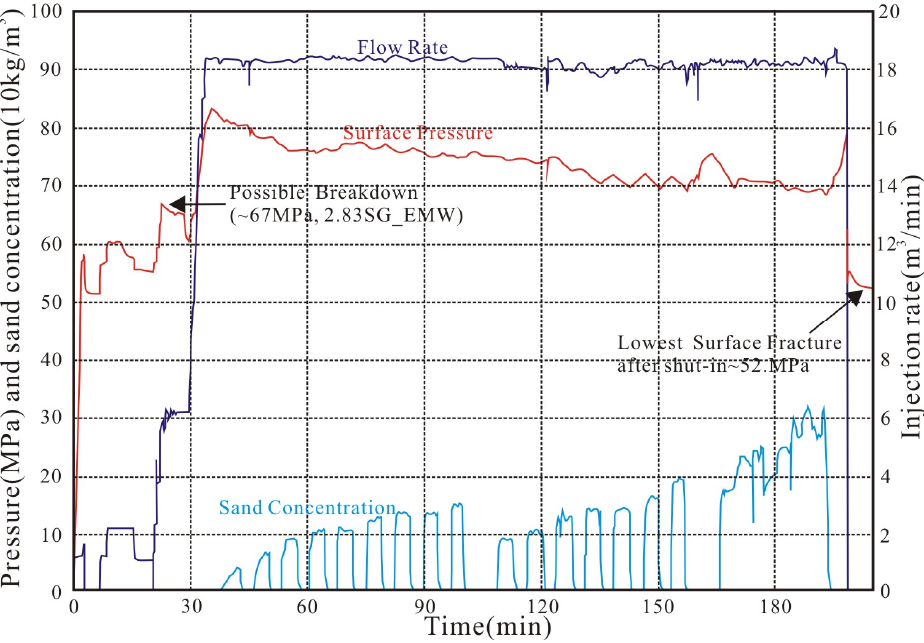
Figure 14. Pressure curve of hydraulic fracturing in W206.